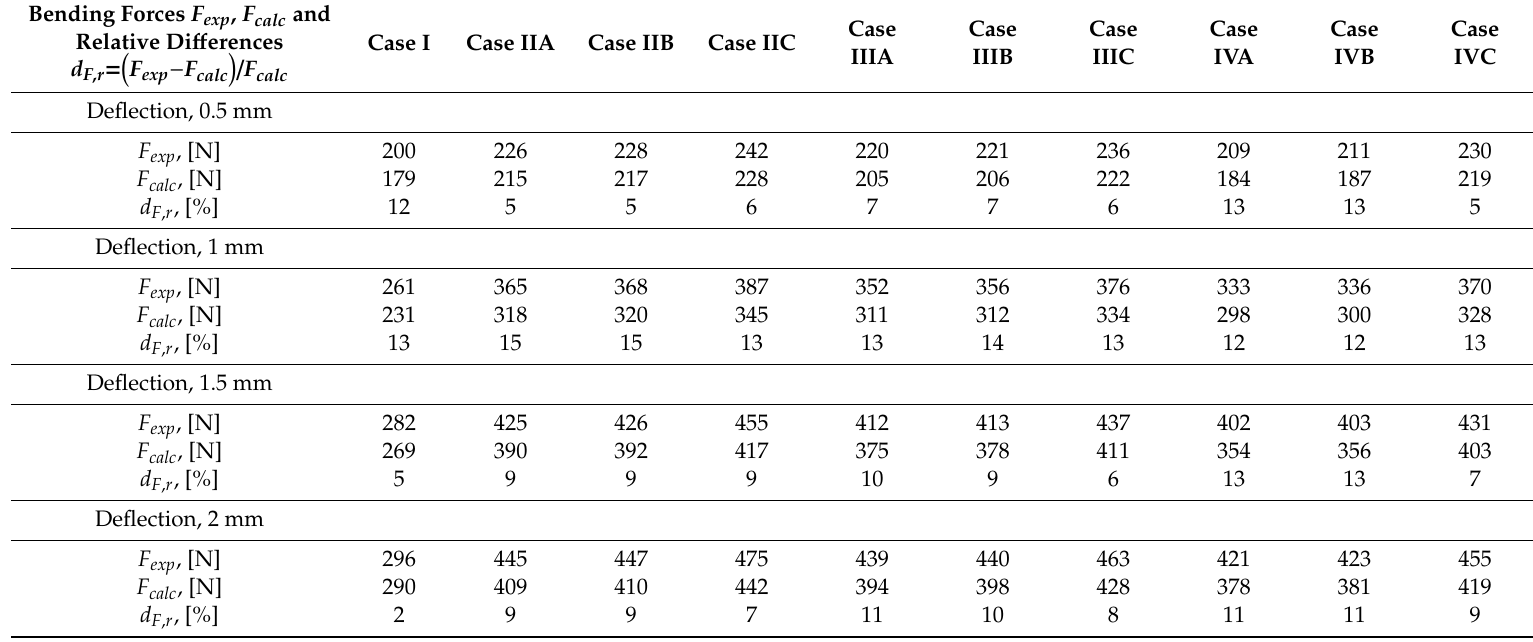
Table 10. Experimental and modeled bending forces F exp and F calc respectively, and their relative di ff erences d F , r at di ff erent deflections w. Bending Forces F exp , F calc and Relative Di ff